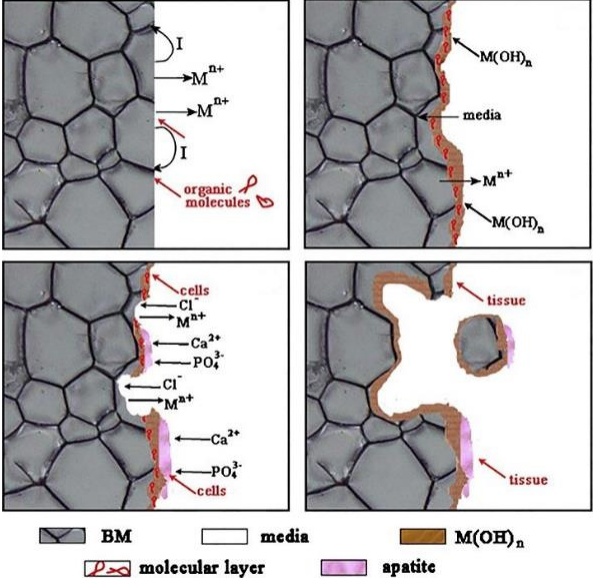
Figure 3. Schematic diagrams displaying the biocorrosion at biodegradable metals/medium surface. Reproduced with permission from [20]. Copyright 2014, Elsevier.